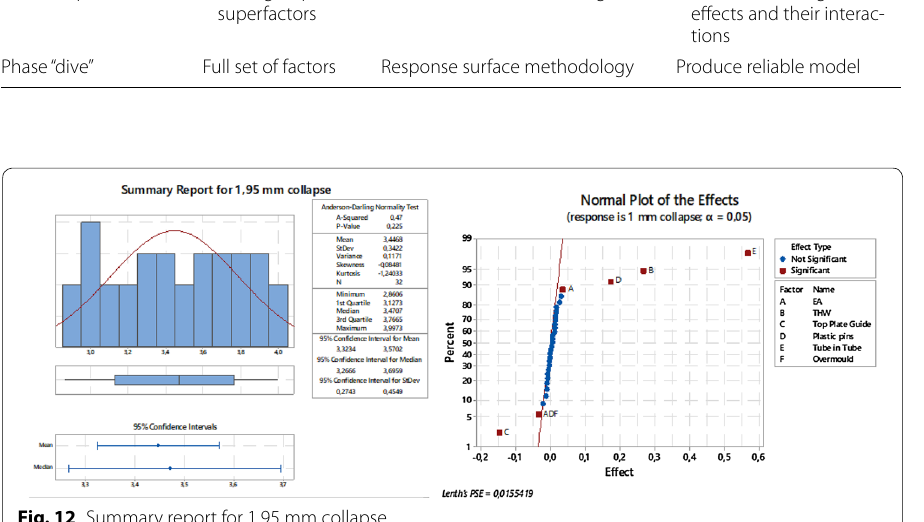
Fig. 12 Summary report for 1.95 mm